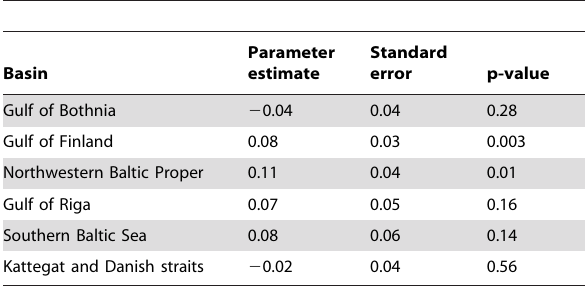
Table 1. Effect of NAO on dinoflagellate proportions in six major basins.